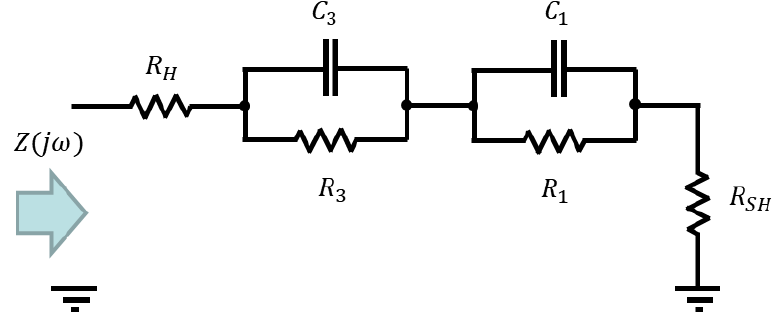
Figure 2. Equivalent circuit used for the parametric identification of the impedance of standard glass dye-sensitized solar cells (DSSC), according to [2].